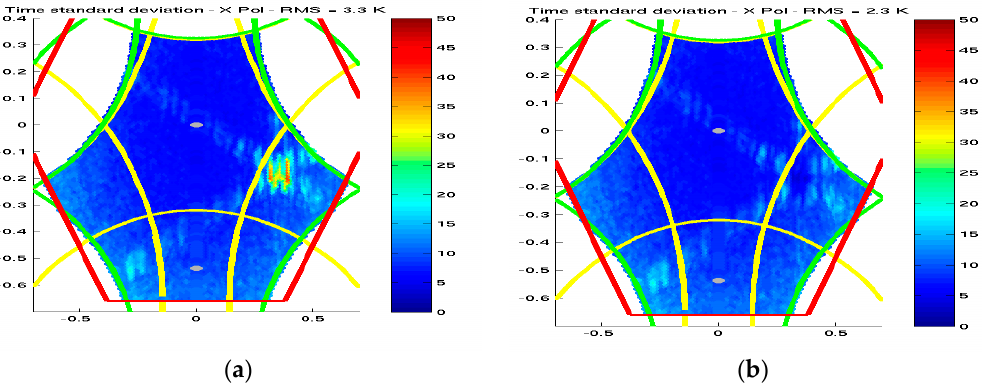
Figure 13. Time standard deviation of 100 snapshots over the ocean, with the Sun alias present at approximately [0.4, –0.15], with the old Sun correction ( a ) and the super-sampled correction ( b ).